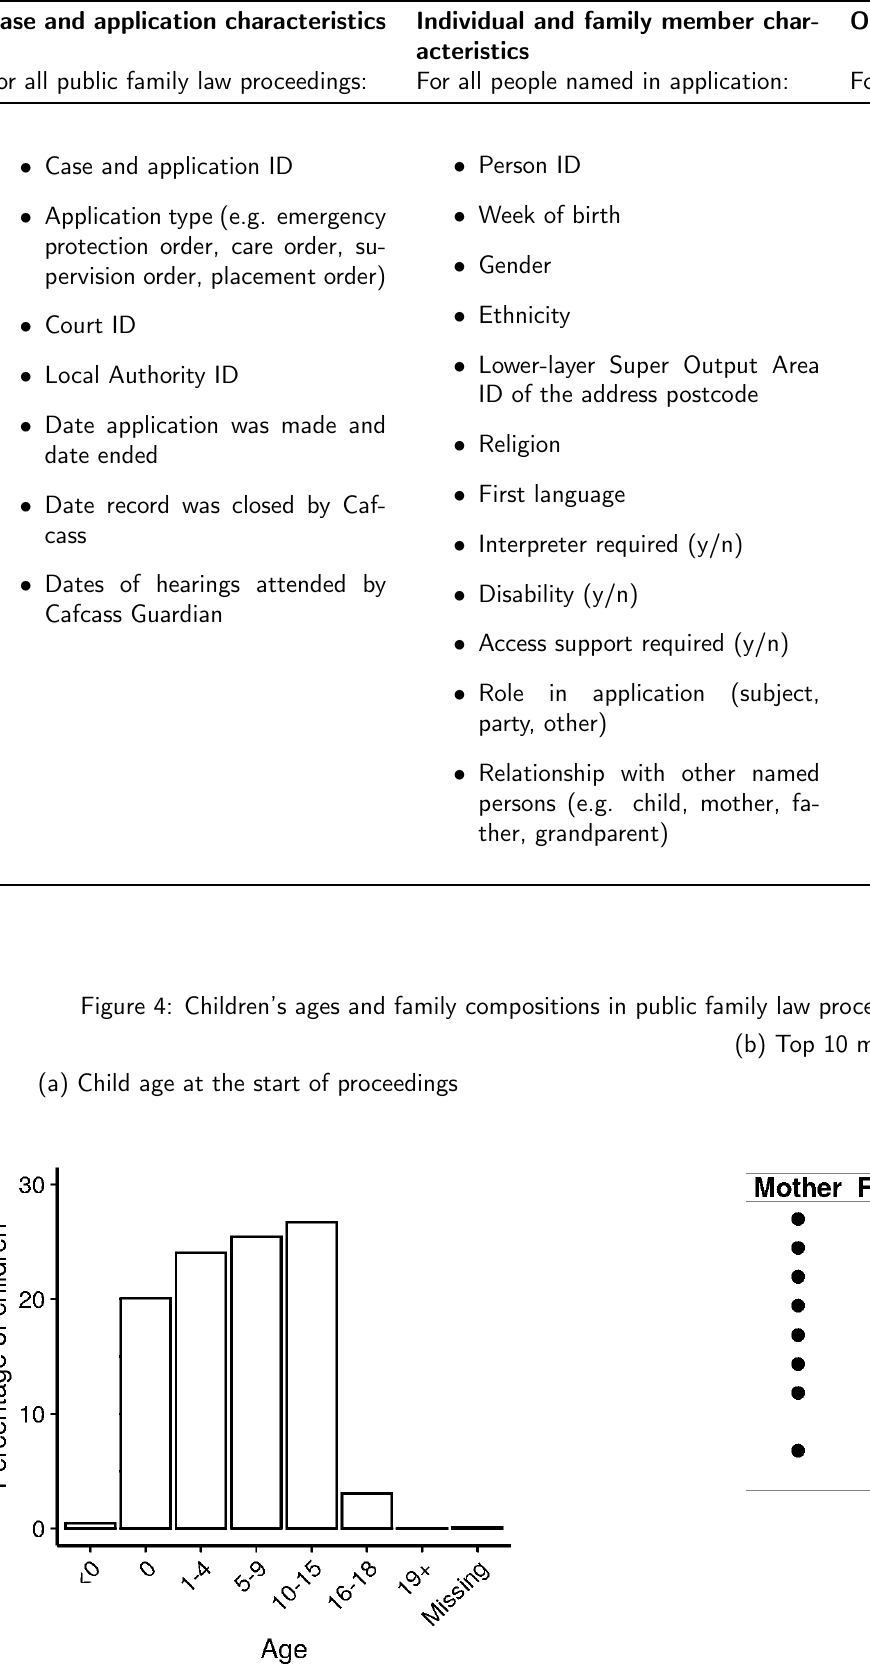
Table 1: Measures and characteristics available in the pseudonymised Cafcass data extract.